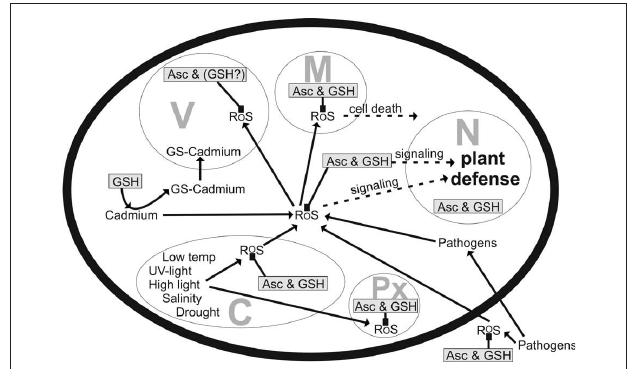
FIGURE 2 | Compartment-specific production of reactive oxygen species (ROS) induced by different stress conditions and possible detoxification and signaling pathways involving ascorbate (Asc) and glutathione (GSH) and ROS. C, chloroplast; M, mitochondrium; N, nucleus; Px, peroxisome; V,